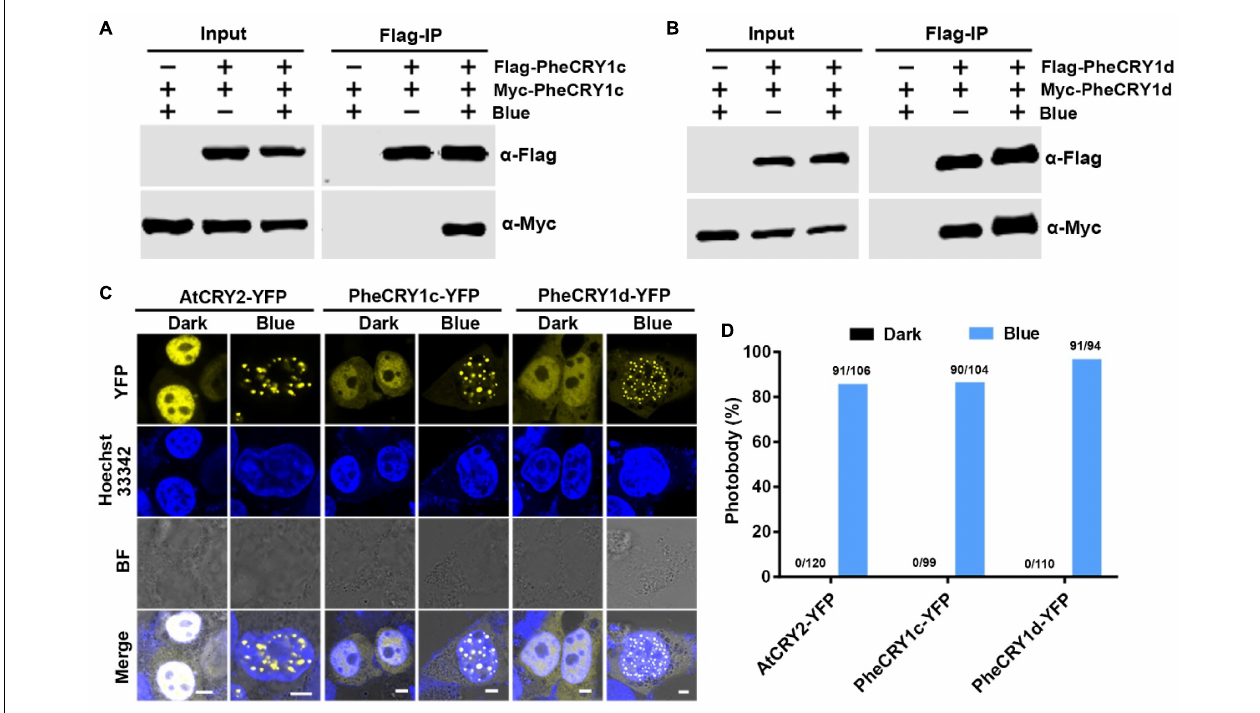
FIGURE 3 | Bamboo PheCRY1s undergo blue light-enhanced homo-oligomerization. (A,B) Co-immunoprecipitation (co-IP) assays showing the blue light-enhanced homo-oligomerization of PheCRY1 in HEK293T cells. Cells co-expressing Flag-PheCRY1 and Myc-PheCRY1 were kept in the dark (Blue –) or exposed to 100 µ mol − 2 s − 1 of blue light for 2 h (Blue +). Immunoprecipitations (IP) were performed with Flag-conjugated beads. The IP and co-IP products were detected with anti-Flag and anti-Myc antibodies, respectively. (C) Confocal images showing the photobody formation of PheCRY1 in response to blue light in HEK293T cells. Cells were kept in the dark or exposed to blue light (100 µ mol m − 2 s − 1 ) for 1 h. Before imaging, cells were fixed in 4% formaldehyde. Hoechst staining shows the nuclei. BF, bright field; scale bar, 5 µ m. (D) Quantitative analysis of PheCRY1-YFP photobody formation in (C) . Photobody (%) is the percent of nuclei with photobodies among counted nuclei. The number of nuclei with photobodies and total counted nuclei was indicated above the